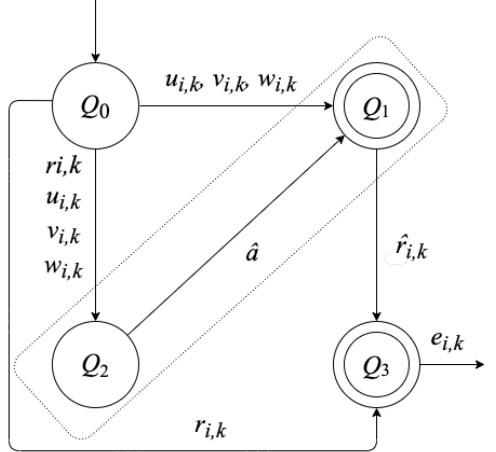
Figure 1. Diagram states R for the reconstruction of response time dynamics of a task with high priority over RT-Linux.